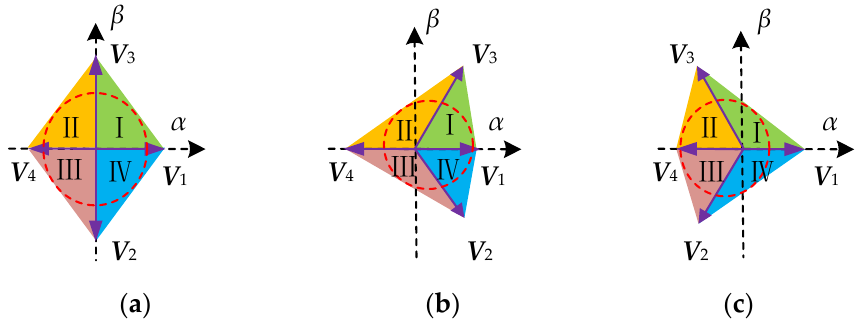
Figure 2. Voltage space vectors with a Phase A fault. ( a ) v c 1 = v c 2 ; ( b ) v c 1 < v c 2 ; ( c ) v c 1 > v c 2 . Table 1. Voltage vectors when switching device of Phase A has a